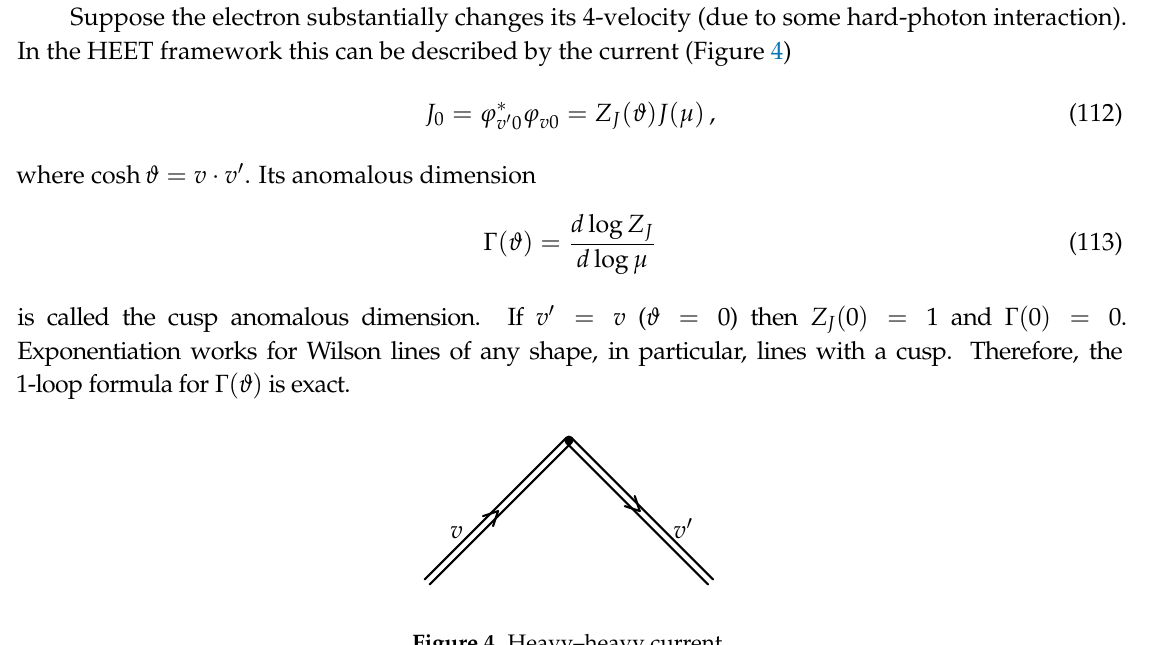
Figure 4. Heavy–heavy